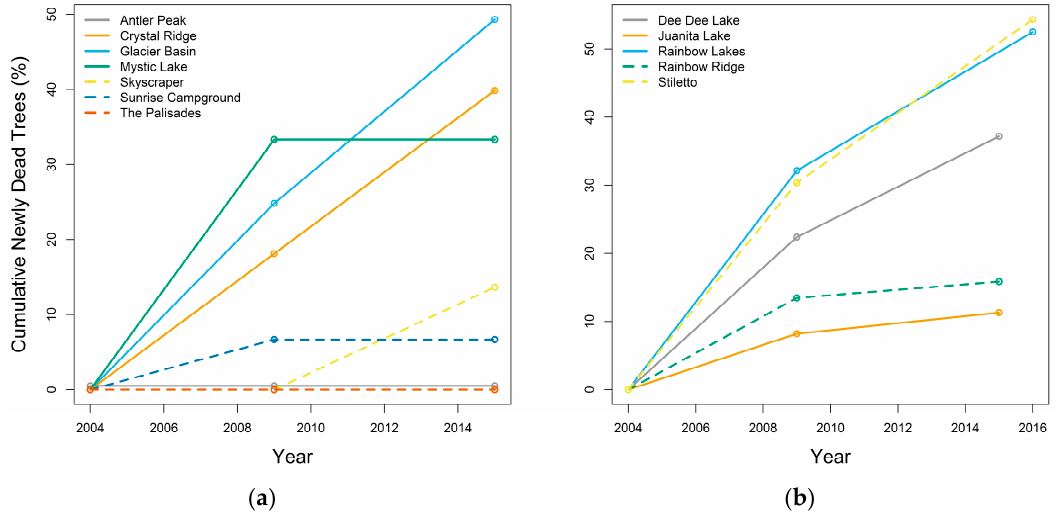
Figure 4. Percent newly dead trees across the study period for sites in ( a ) Mount Rainier National Park and ( b ) North Cascades National Park Service Complex. 2004 is graphed at zero to indicate the baseline.